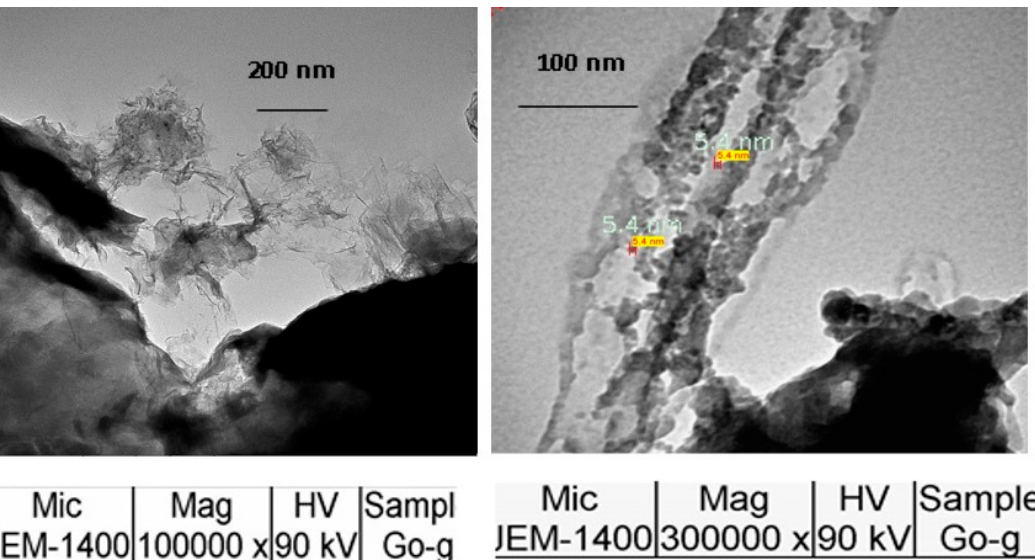
Figure 3. SEM analysis of GO.